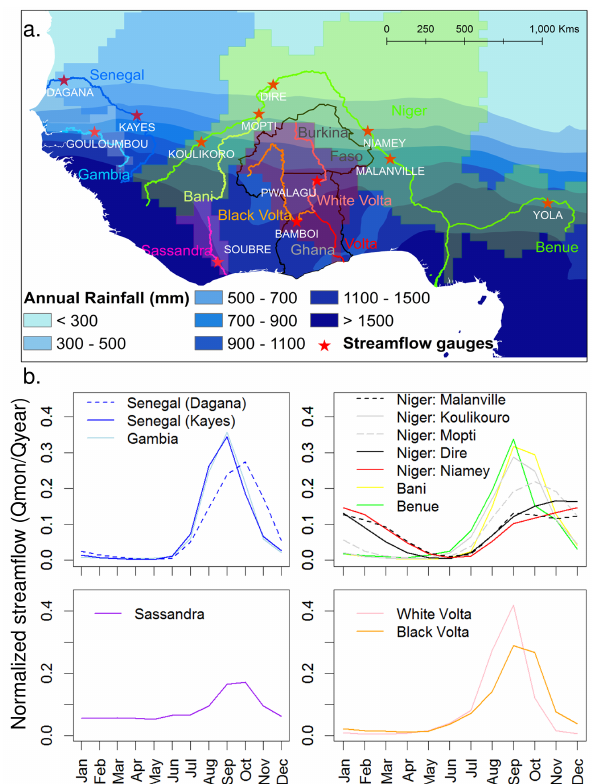
Figure 1. (a) Rivers selected in this study. Rainfall values are from CRU 3.1 data set (1970/2009) (Mitchell and Jones, 2005). Note that White Volta is also named Nakambe River. (b) Mean normalized hydrographs of the studied river basins ( Q month / Q year ). Historical data come from the Global Runoff Data Centre (2011) (GRDC) and are for different time periods, depending on the river, but with at least 27